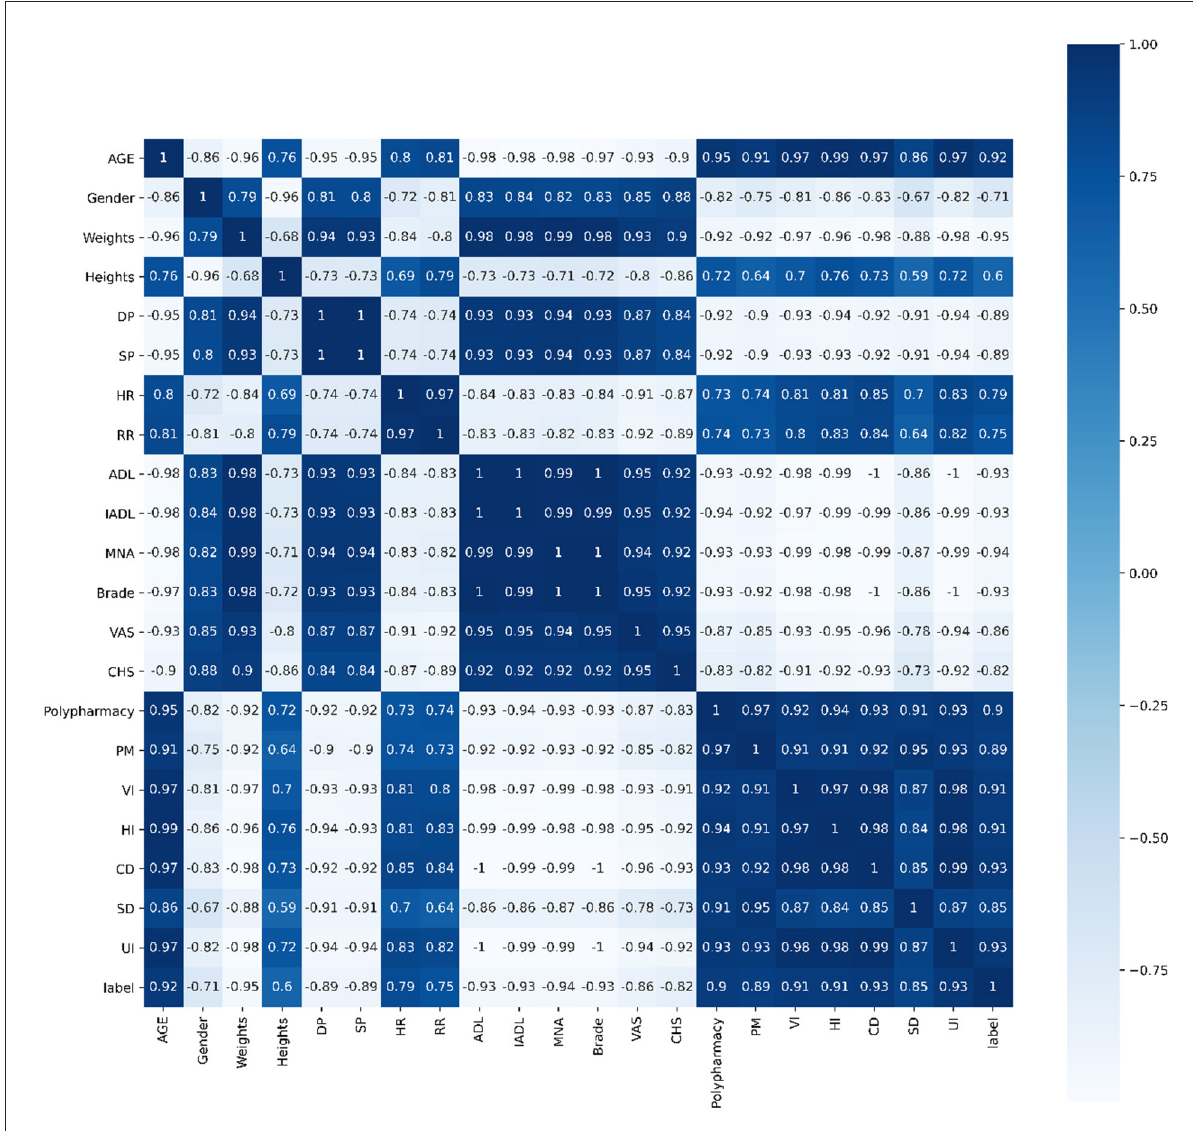
FIGURE9 Spearman’s correlation of all 21